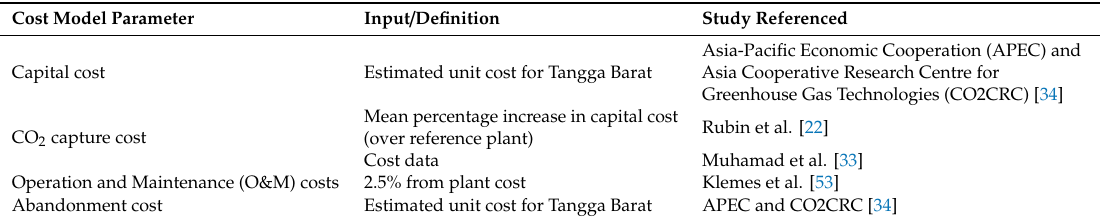
Table 3. Input and definition of the cost